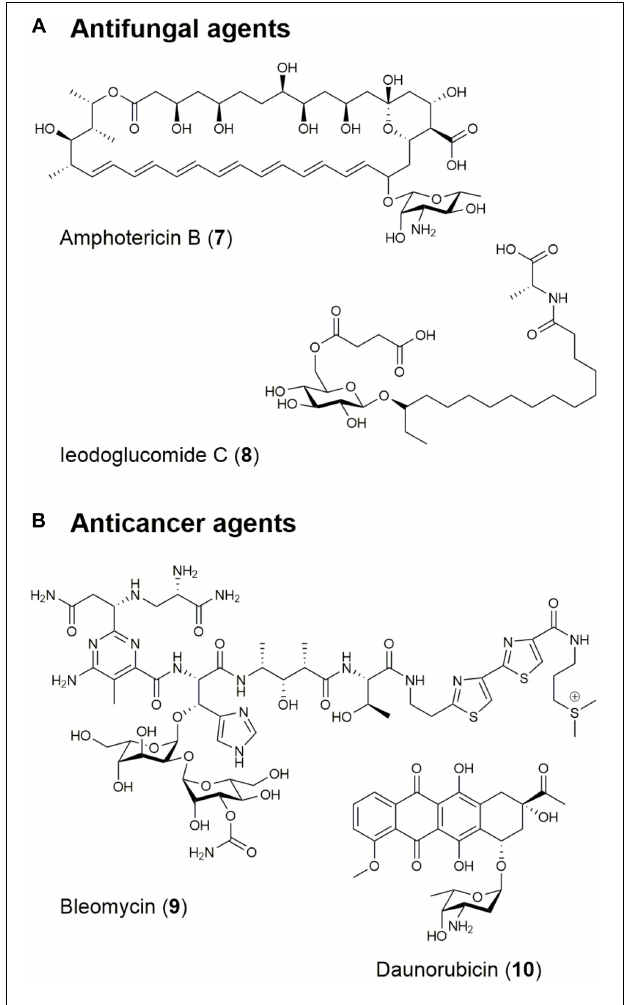
FIGURE 2 | Structures of natural products with (A) antifungal and (B) anticancer/antitumor activities.